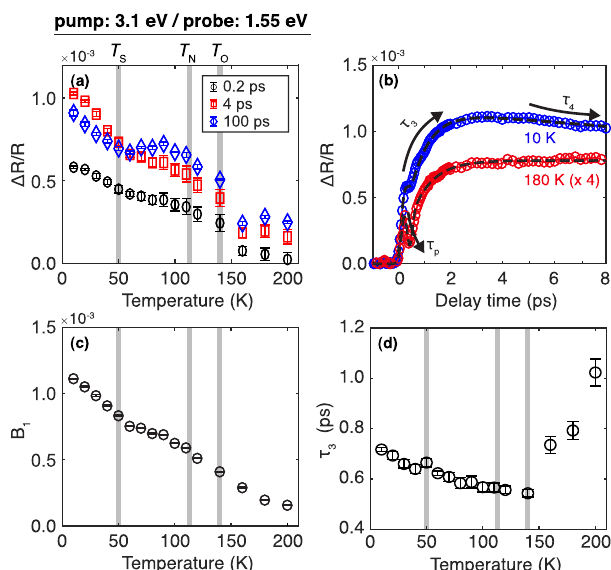
Fig. 4 Analysis of the temperature-dependent re fl ectivity transients ( Δ R / R ) after 3.1 eV photoexcitation. a Δ R / R at time delays of 0.2 ps (black circles), 4 ps (red squares), and 100 ps (blue diamonds). We also plot the amplitude B 1 (orange circles) obtained from our curve fi ts. b Transient re fl ectivity data at temperature T = 20 K (blue circles) and 180 K (red circles), along with fi ts using the model described in the text. The data and fi t curve at 180 K are scaled up by a factor of four for clear comparison. c The rise time ( τ 3 ) and (d) decay time ( τ 4 ) obtained from the ultrafast dynamics in (b), revealing a clear anomaly across the antiferro- type orbital ordering temperature T O = 140 K. The error bars were calculated as described in